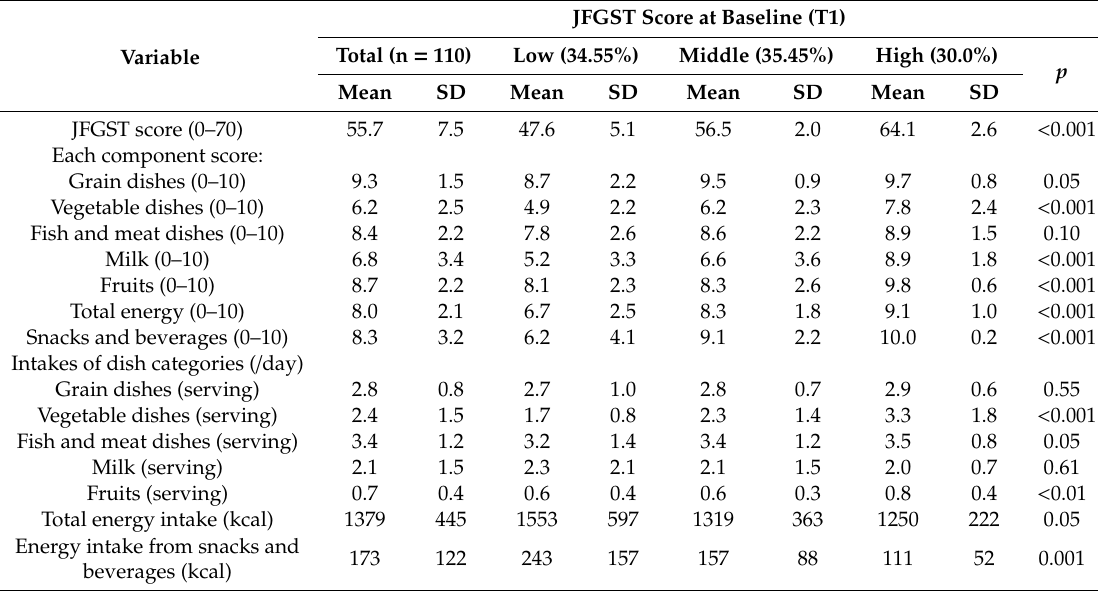
Table 3. Distribution of the scores on the adherence to the Japanese Food Guide Spinning Top (JFGST) and the intakes of each dish category according to the JFGST score at baseline (T1) ( n =